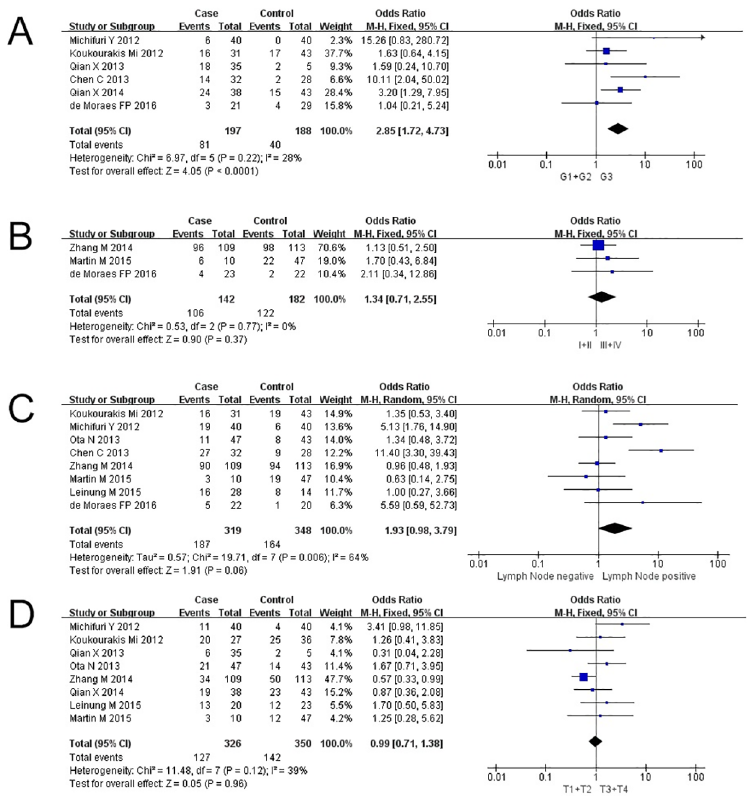
Fig 2. Forest plot describing the association between ALDH1 expression and odds ration (OR) for clinical pathological features. Forest plot of OR for the (A) differentiation grading,(B) clinicalstaging, (C) lymph node status, (D) tumor T stage of the ALDH1 + group comparedto ALDH1 -